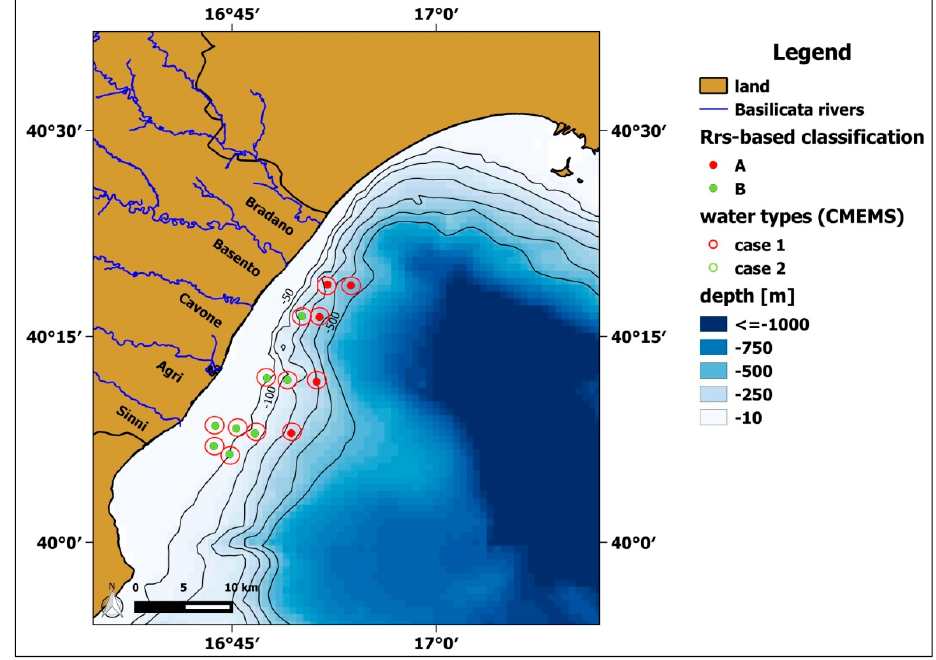
Figure 13. Comparison between the water type masks (averaged value on a 3 × 3-pixel box centered on the location of the in situ chl-a samples) included in the CMEMS-L3 product and the classes derived by the R rs ( λ ) supervised classification implemented on the chl-a samples selected for the match-up analysis (Figure 12). The full circles represent the classes (red and green for classes A and B), while the empty circles the water types (red and green for Case 1 and Case 2 waters). The continuous lines are bathymetry depths ranging from 50 to 500 m depth.